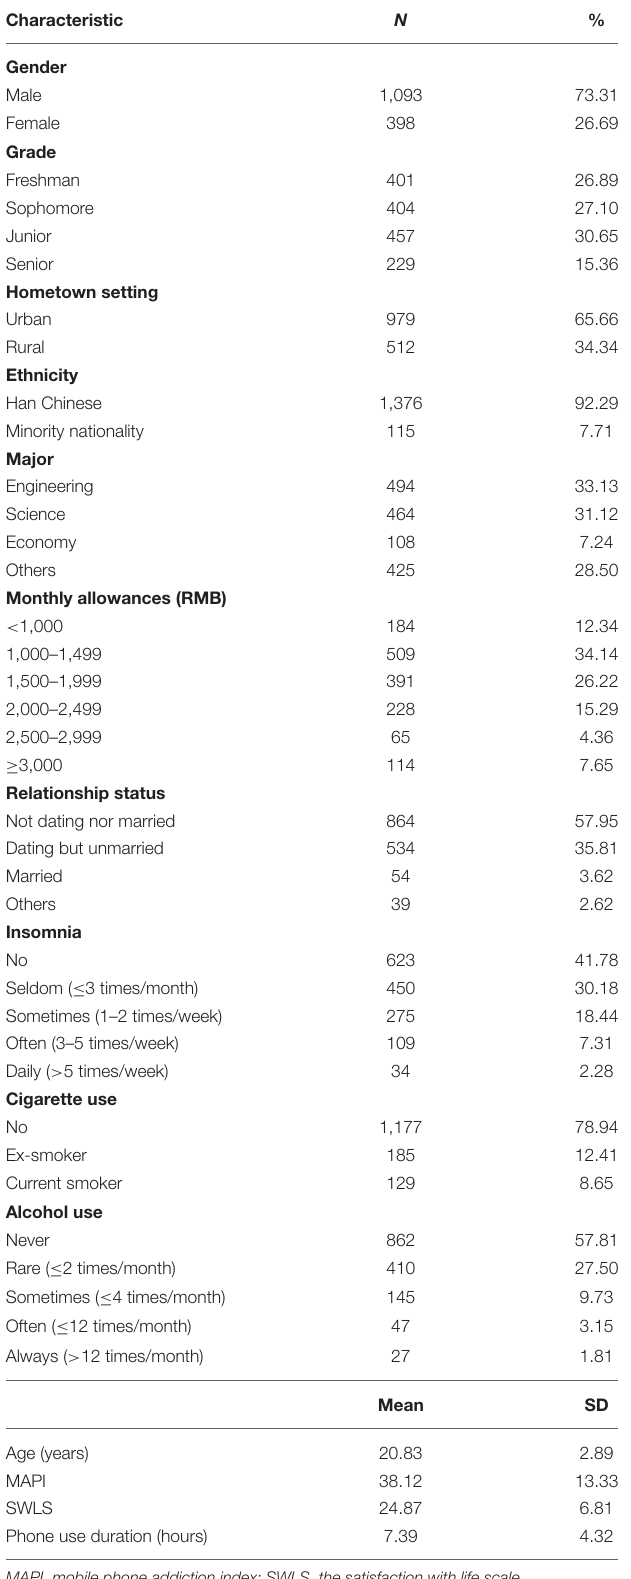
TABLE 1 | Characteristics of 1,491